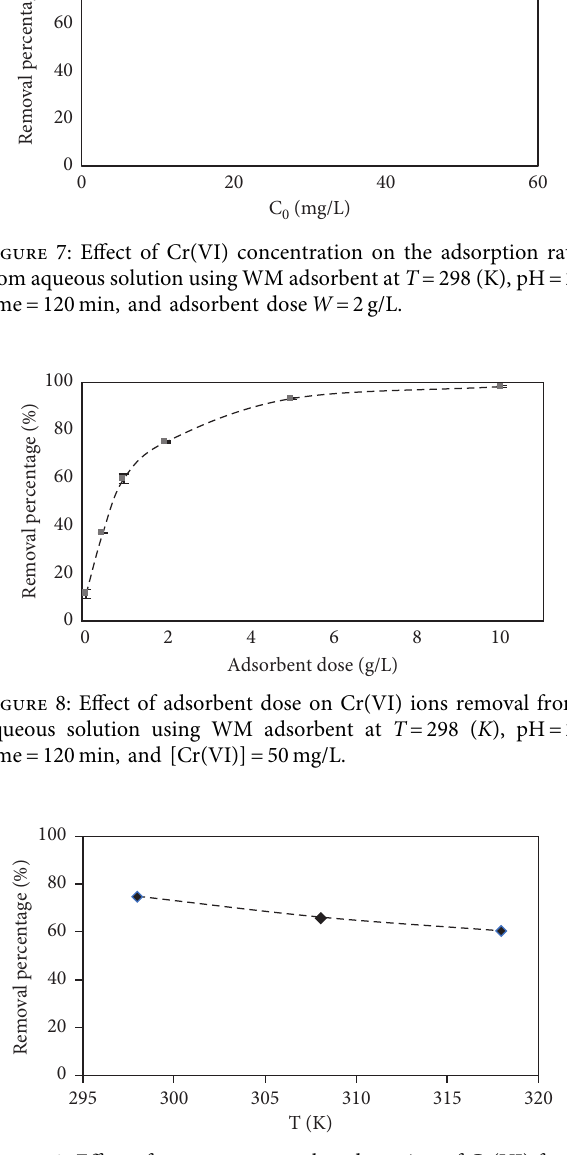
Figure 9: Effect of temperature on the adsorption of Cr(VI) from aqueous solution using WM adsorbent at pH � 2, time � 120min, adsorbent dose W � 2g/L, and [Cr(VI)] � 50mg/L.